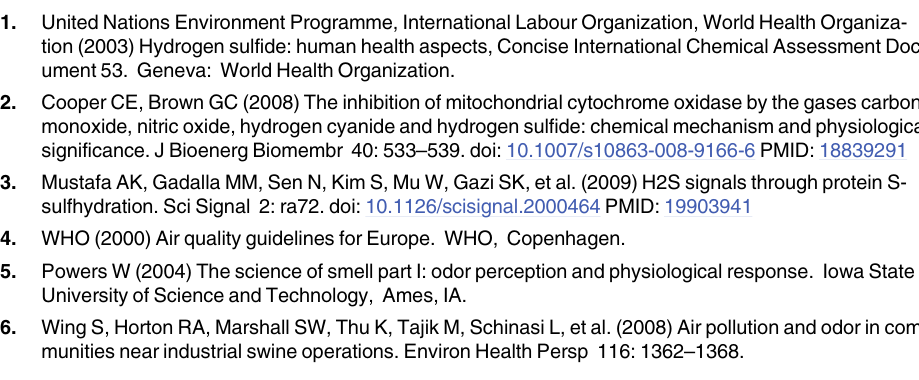
S2 Table. Associations between daily emergency hospital visits with heart diseases, respira- tory diseases, and stroke as primary diagnosis for 7.00 μ g/m 3 changes in H tions (introduced as continuous variable) in fully adjusted models for lags